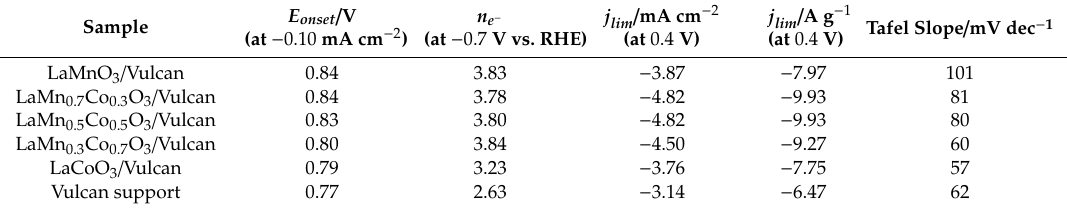
Table 3. Onset potential, number of electrons, limiting current density, and Tafel slope obtained for the ORR reaction at perovskite materials mixed with Vulcan with a 1:1 mass ratio.